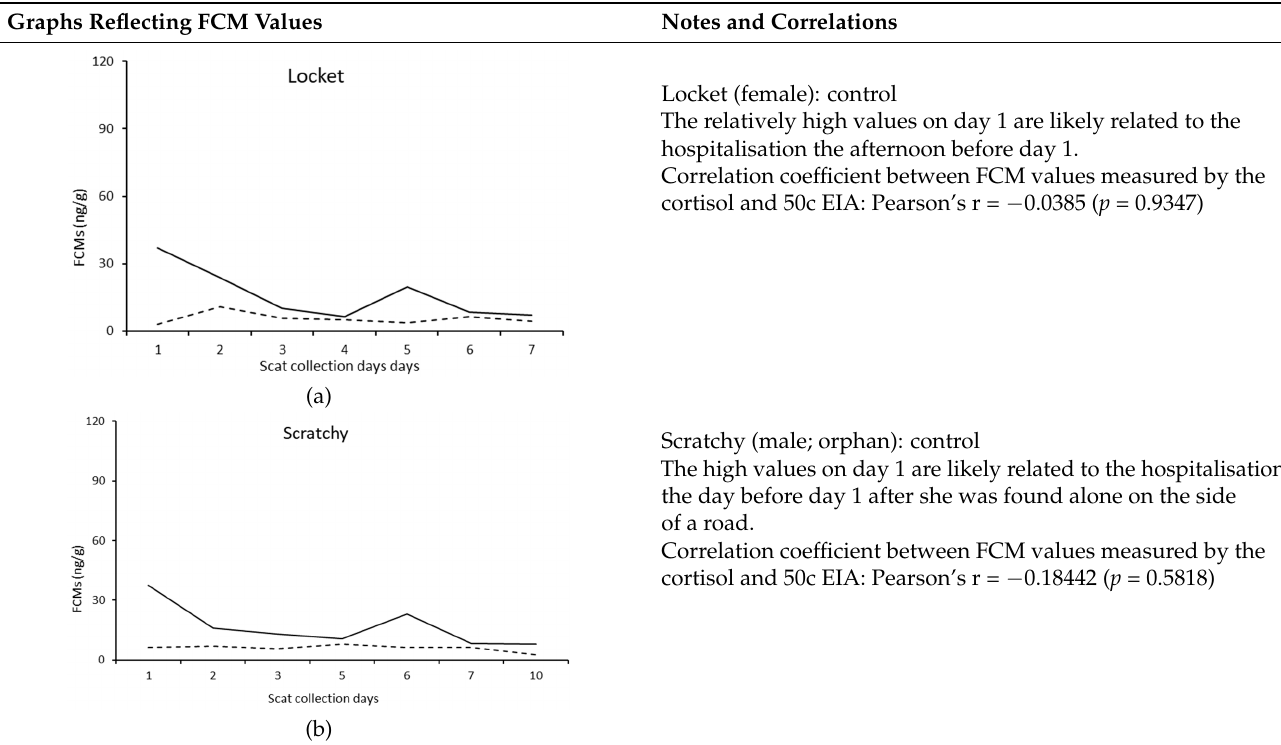
Table A1. Summary statistics for FCM (faecal cortisol metabolite) levels (ng/g) measured by 50c and cortisol EIAs (enzyme immunoassays) for control koalas in each location (AZ = Australia Zoo Wild- life Hospital; ML = The Mill).